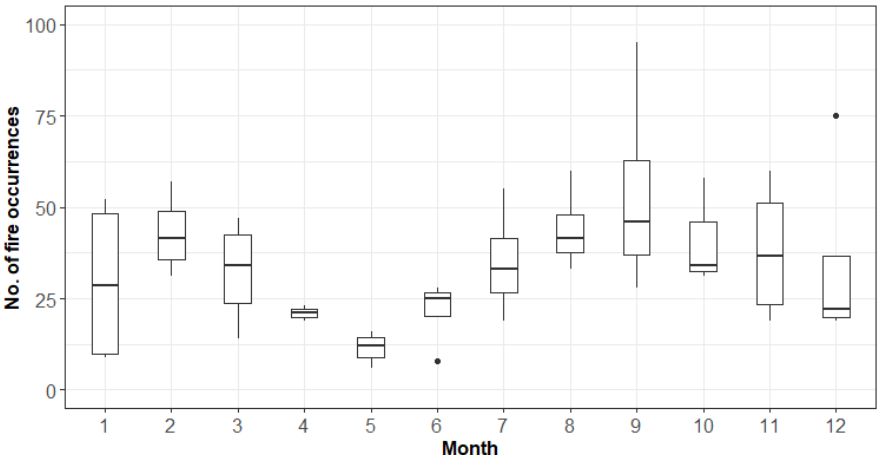
Figure 4. Distribution of fire events (dependent variable) by month between the study period (2010 to 2016) across the studied area in the Brazilian savanna region.